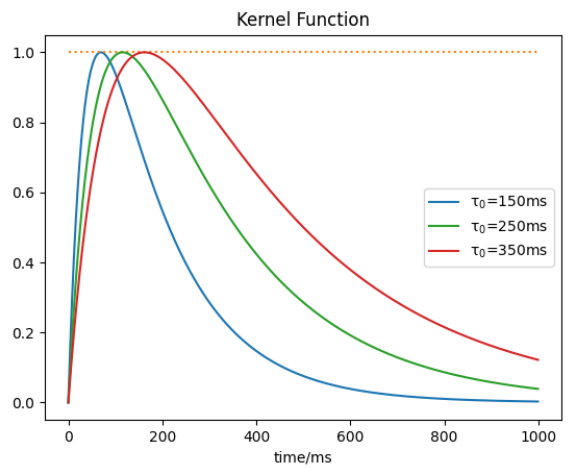
Figure 1. Kernel function.